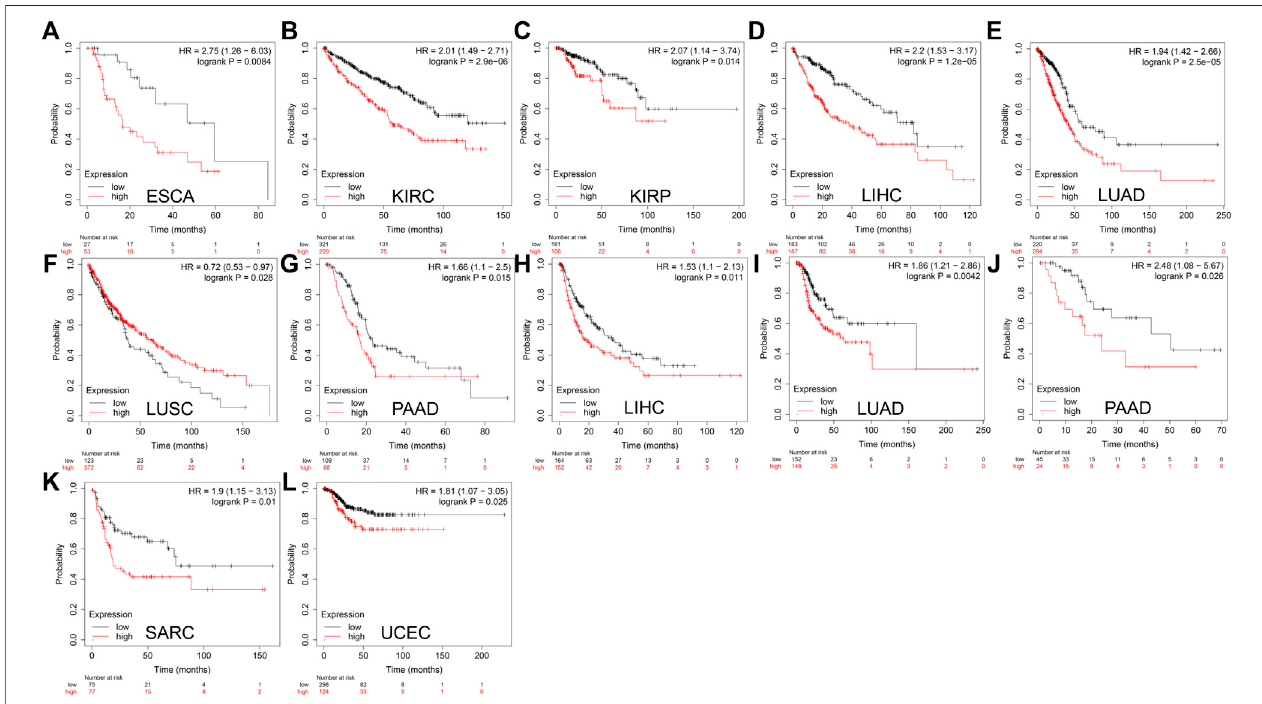
FIGURE 11 | Kaplan-MeieranalysissuggeststhatenhancedDTYMKexpressioncorrelatedwithapooroutcomeinmostcancers.DTYMKexpressionwassigni fi cantlycorrelatedwith overallsurvivalofESCA (A) ,KIRC (B) ,KIRP (C) ,LIHC (D) ,LUAD (E) ,LUSC (F) ,andPAAD (G) .DTYMKexpressionwassigni fi cantlycorrelatedwithdisease-freesurvivalofLIHC (H) ,LUAD (I) , PAAD (J) , SARC (K) and UCEC (L) . ACC, Adrenocortical carcinoma; BLCA, Bladder urothelial carcinoma; BRCA, Breast invasive carcinoma; COAD, Colon adenocarcinoma; ESCA, Esophagealcarcinoma;HNSC,Headandnecksquamouscellcarcinoma;KIRC,Kidneyrenalclearcellcarcinoma;LGG,Brainlowergradeglioma;LIHC,Liverhepatocellularcarcinoma; LUAD,Lungadenocarcinoma;LUSC,Lungsquamouscellcarcinoma;OV,Ovarianserouscystadenocarcinoma;PAAD,Pancreaticadenocarcinoma;PRAD,Prostateadenocarcinoma;READ, Rectum adenocarcinoma; SARC, Sarcoma; STAD, Stomach adenocarcinoma; TGCT, Testicular germ cell tumors; UCEC, Uterine corpus endometrial carcinoma.